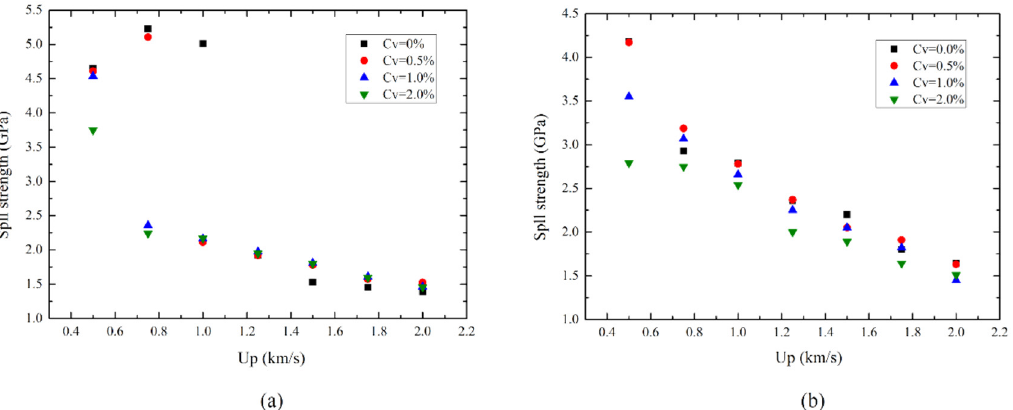
Figure 10. Variation of spall strength as a function of piston velocity impacted along different crystalline directions ( a ) [0001] and ( b ) [10 – 10] with different vacancy concentrations.